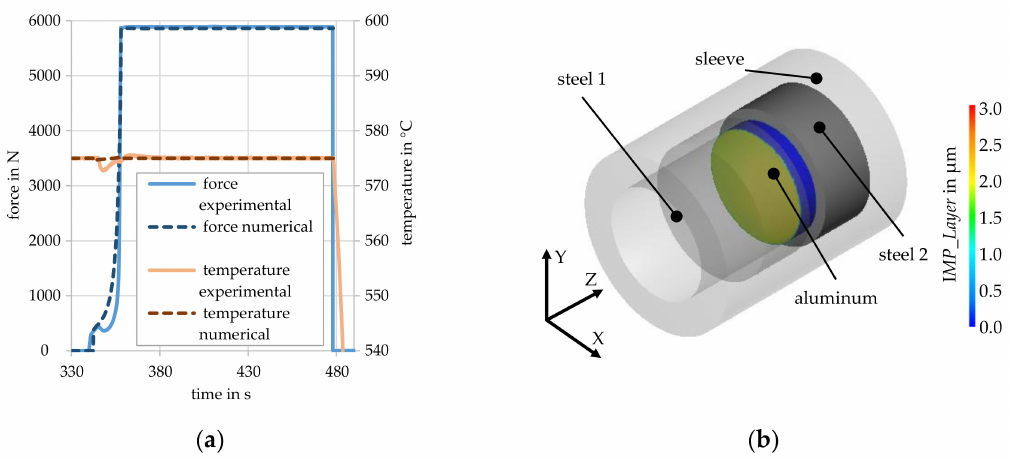
Figure 13. Numerical simulation of the analogy experiment at a temperature of 575 ◦ C, a forming time of 120 s, and a force of 5890 N: ( a ) comparison of force–time and temperature–time curves, ( b ) simulated thickness of the intermetallic phase